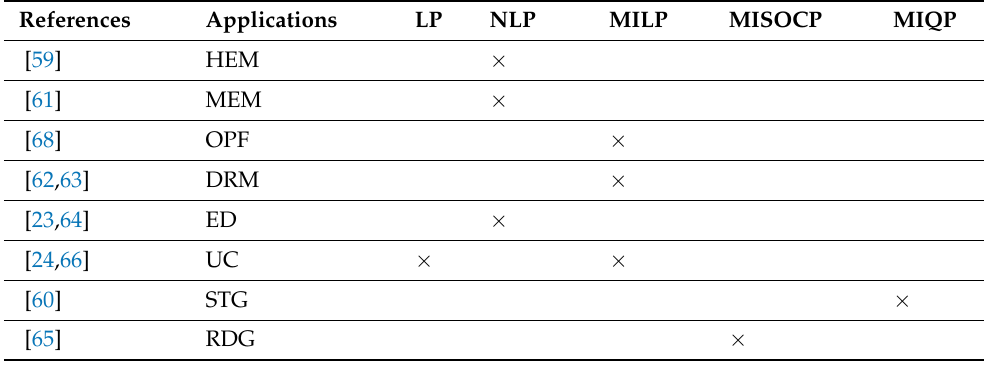
Table 2. Applications of stochastic optimization and its problem